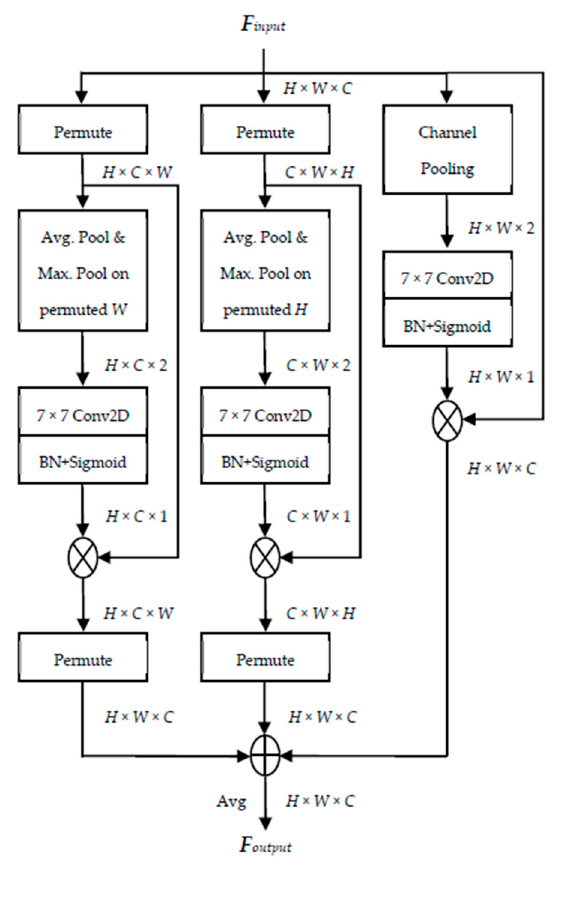
Figure 1. Graphical outlines of various attention modules. ( a ) SE [3]; ( b ) ECA [4]; ( c ) SCA [13]; ( d ) CBAM [2]; ( e ) ECBAM [12]; ( f ) CA [5]; ( g ) TA [6]; ( h ) DAA [14].